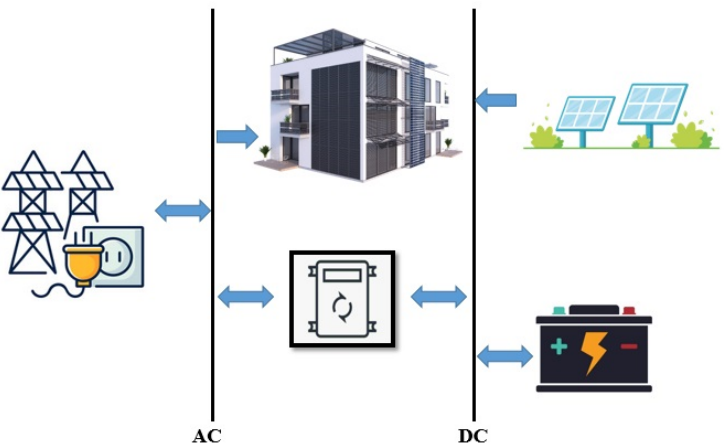
Figure 8. Schematic of the simulated system.